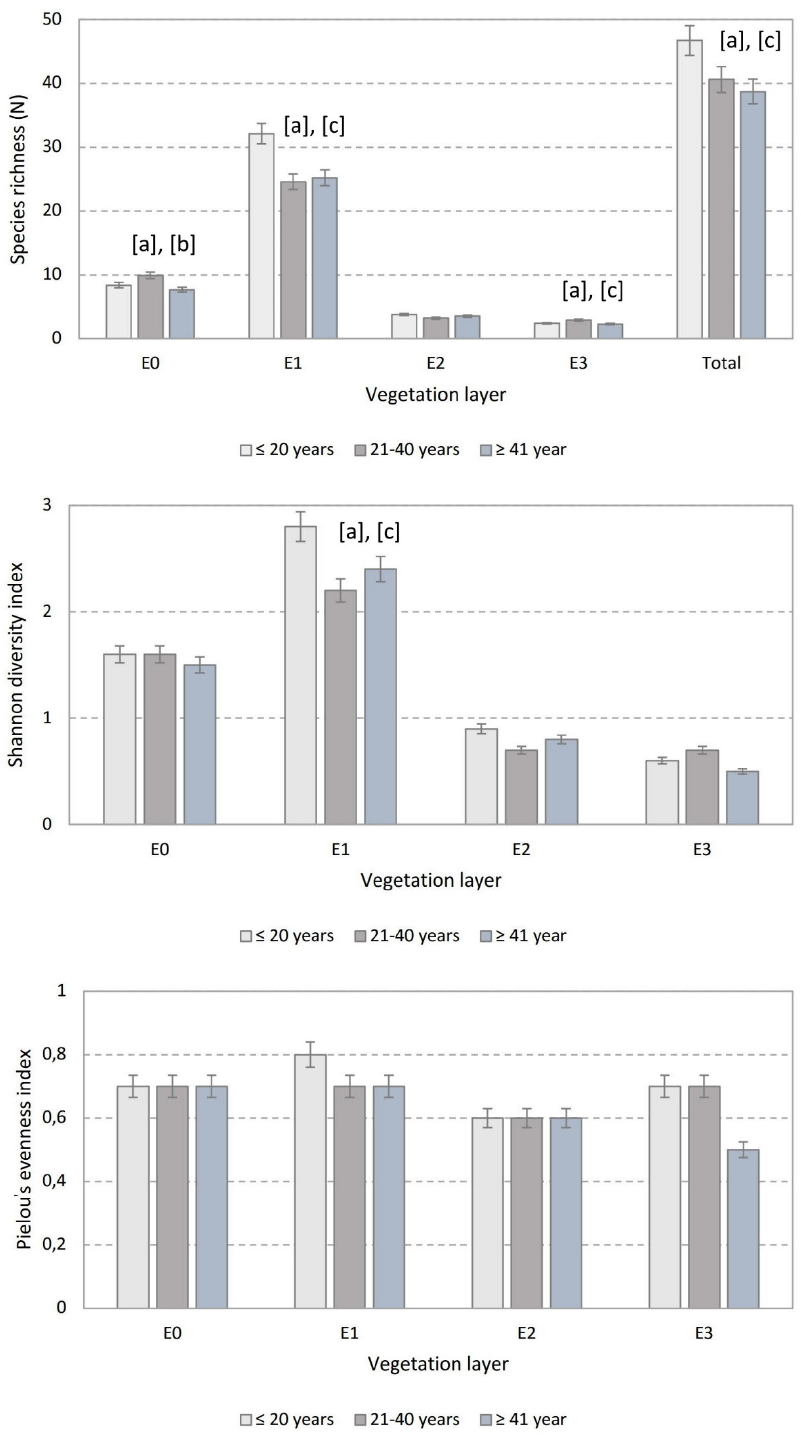
Figure 3. Species richness (upper part), Shannon-Wiener index (middle) and evenness (bottom) by vegetation layer in young ( ≤ 20 years, medium-old (21–40 years) and old ( > 41 years) edges. Significant di ff erences are shown with letters: ( a )—between young and medium old edges, ( b )—between medium-old and old edges and ( c )—between young and old edges ( p < 0.05). n = 90, values are means ± standard error is